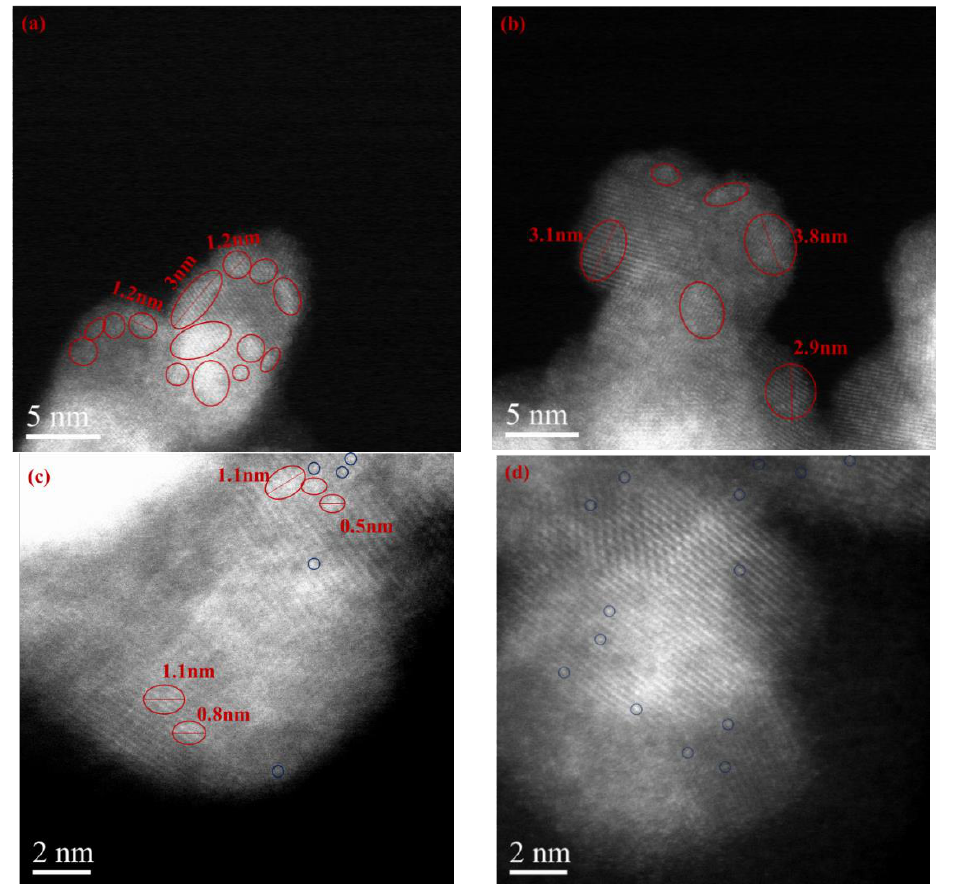
Figure 4. HAADF-STEM images of ( a ) the c-1-RuST sample, ( b ) the o-1-RuST sample, ( c ) the c-0.5- RuST sample and ( d ) the c-0.1-RuST sample. Representative Ru clusters and single-atom Ru in each sample and the diameters of some of the Ru clusters are also marked in the figure. Table 1. CO pulse adsorption experiment results of samples with different RuO x